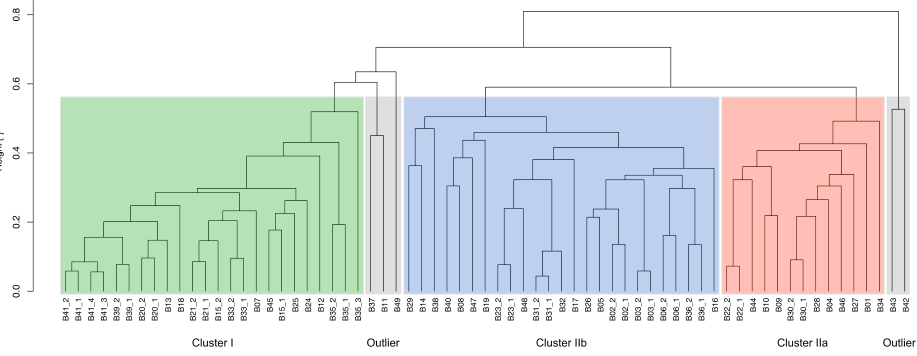
Figure 3. Tree diagram based on a McQuitty (dis)similarities matrix calculated from the taxonomic profiles of the analyzed 67 anaerobic digesters from 49 agricultural biogas